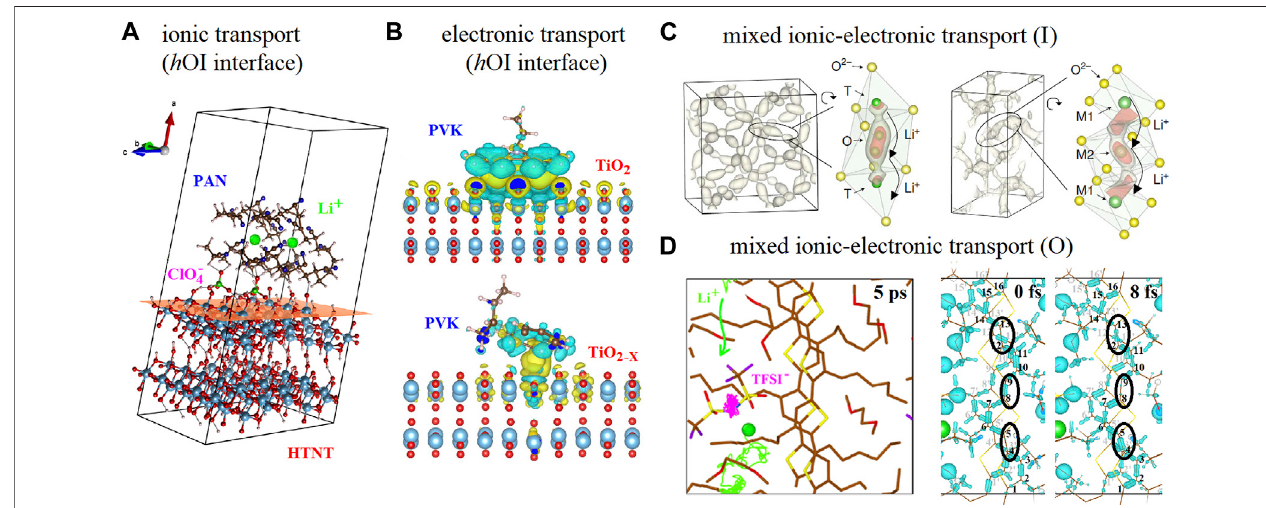
FIGURE 2 | (A) AIMD calculations showing the Li + - ClO 4 − ionic-pair dissociation for an h OI interface based on polyacrylonitrile (PAN) and titanate surface (HTNT) [ Portion of fi gure adapted/altered minimally with permission from American Chemical Society ] (Pignanelli et al., 2018a). (B) DFT calculations showing the electronic charge transfer interactions between vinyl carbazole monomer (PVK) and TiO 2 surface including oxygen vacancies (TiO 2-x ) [ Portion of fi gure adapted/altered minimally with permission from Elsevier ] (Mombrú et al., 2019b). (C) AIMD calculations showing the probability density of Li + spatial occupancy and the elongation feature of probability density along the migration channel with the corresponding isosurfaces for LLZO and LATP [ Portion of fi gure adapted/altered minimally with permission from Nature Publishing Group ] (He et al., 2017). (D) AIMD calculations showing Li + and TFSI − transport at the P3HT side chain region mediated by glycol molecules (t < 5 ps) and the electron-phonon mediated electronic transport at the P3HT backbone (t < 20 fs) [ Portion of fi gure adapted/altered minimally with permission from American Chemical Society ] (Mombrú et al., 2022).